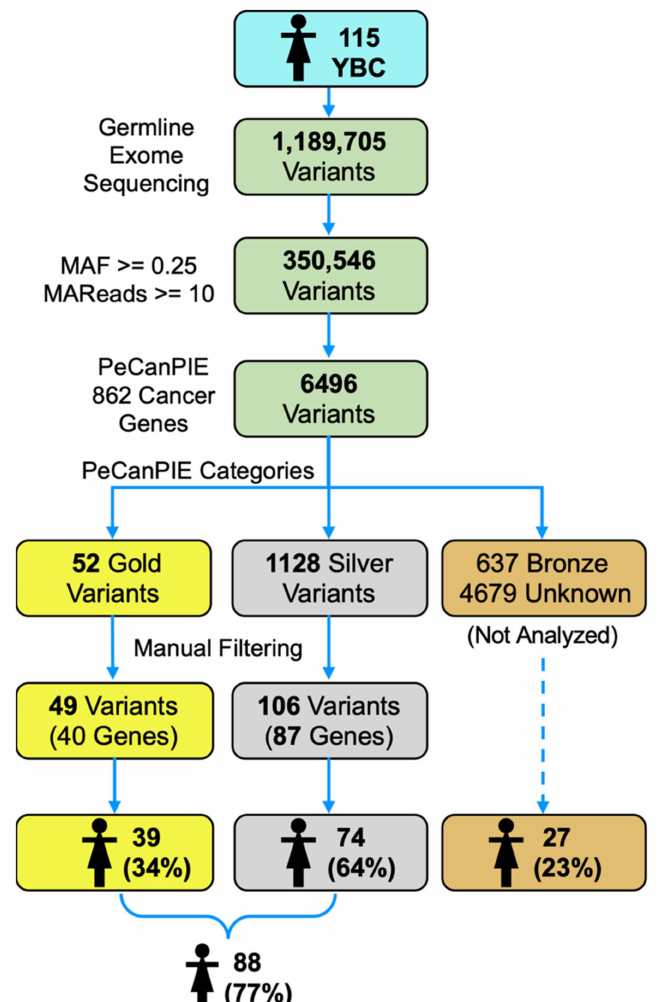
Figure 1. The diagram summarizes all the obtained variants with their exclusion criteria. YBC young Mexican breast cancer